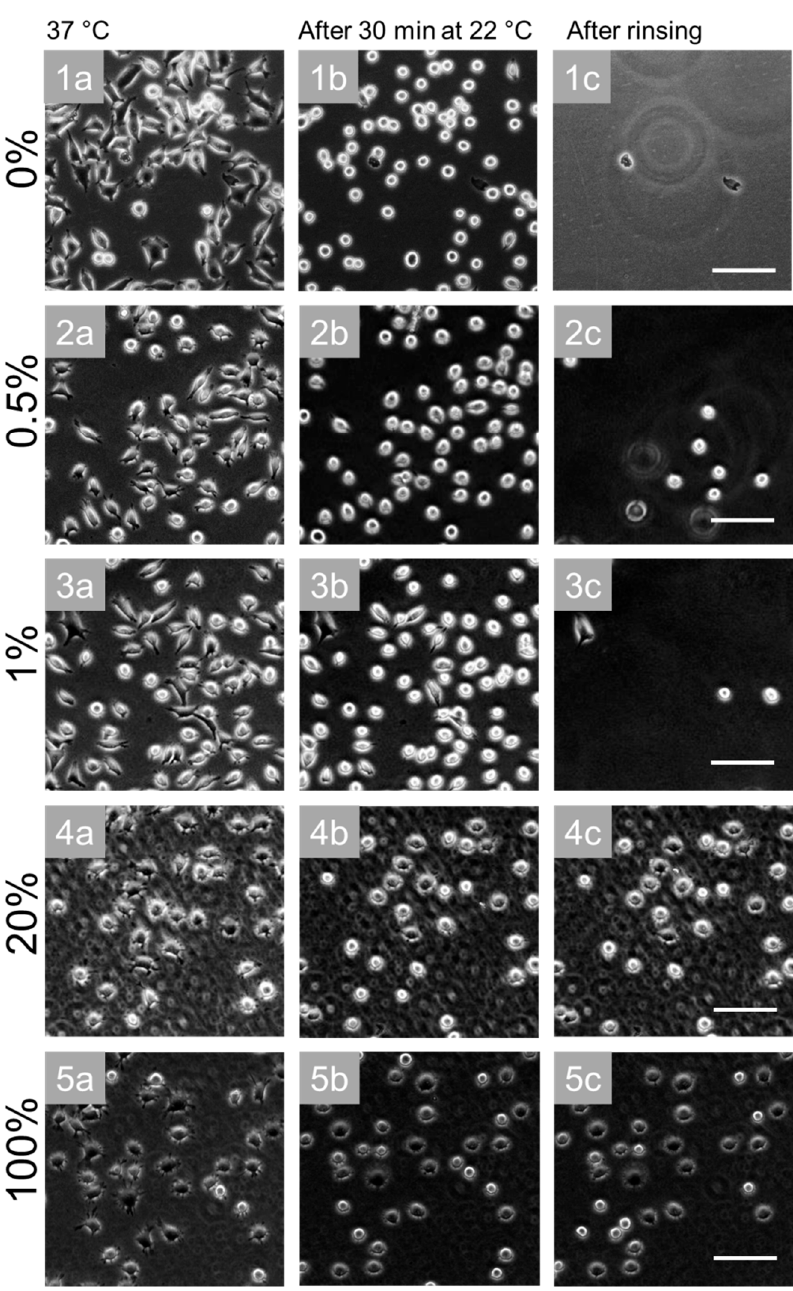
Figure 7. Cell assays to investigate cell detachment on microgel coatings doped with PS beads upon temperature decrease below the LCST. Phase contrast images of L929 mouse fibroblasts cultivated on glass substrates prepared from solutions of different ratios of microgel and PS beads: ( 1a – 1c ) 0% PS beads, ( 2a – 2c ) 0.5% PS beads, ( 3a – 3c ) 1% PS beads, ( 4a – 4c ) 20% PS beads and ( 5a – 5c ) 100% PS beads. After one day, the cells were spreading at 37 °C on all substrates ( a ). After having been exposed to room temperature (~22 °C) for 30 min, the cells reduced the cell surface contact area ( b ). With increasing PS bead concentration, the cell morphology change became less pronounced. After rinsing, nearly all cells were detached from substrates using 0%, 0.5%, and 1% PS beads ( 1 , 2 , 3 ). On surfaces prepared with 20% ( 4 ) and 100% PS beads ( 5 ), nearly all cells remained on the substrate. Scale bars: 100 µm.